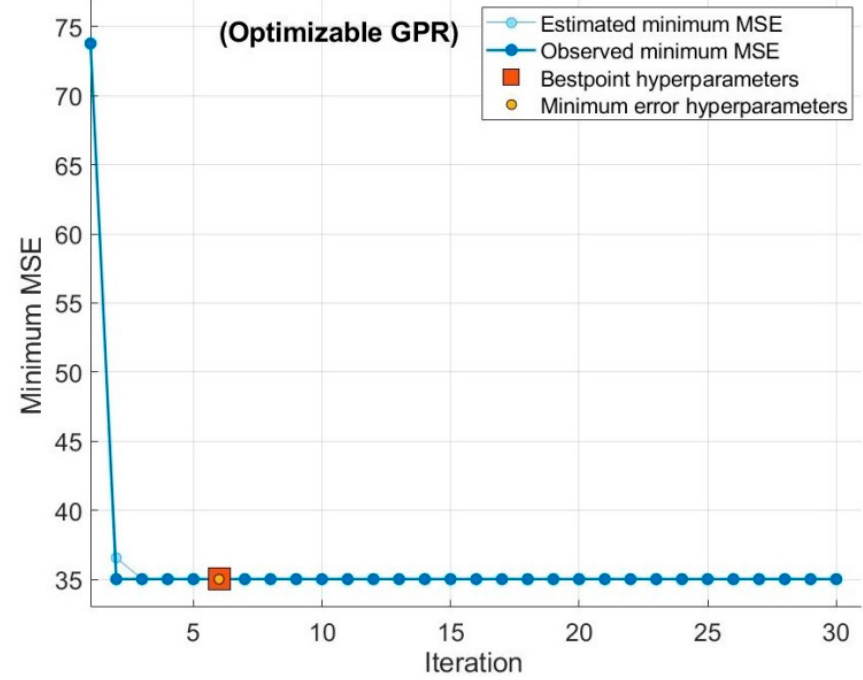
Figure 10. Optimization of Gaussian process regression (GPR).